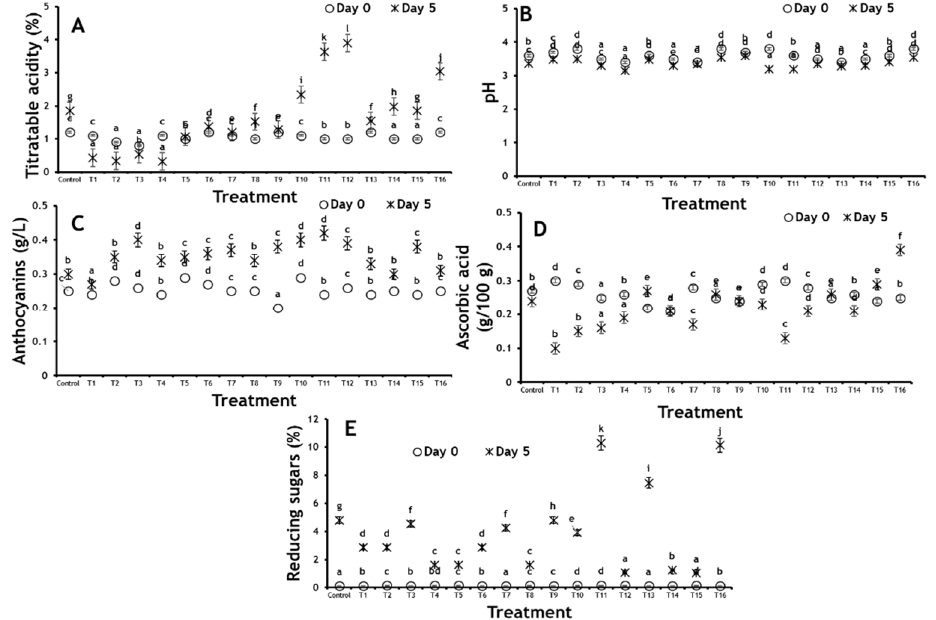
Figure 1. Chemical analysis of minimally processed pomegranate arils stored under active MAP at ambient temperature. Titratable acidity ( A ), pH ( B ), anthocyanins ( C ), ascorbic acid ( D ), and reducing sugars ( E ). Error bar represents the standard deviation from the mean of three independent replicates. The mean values followed by lowercase alphabets (a–l) among the treatments (T1–T16 and control) were significantly different ( p < 0.05) on the basis of Duncan’s multiple range test. MAP = modified atmosphere packaging. For treatment codes, refer to Table